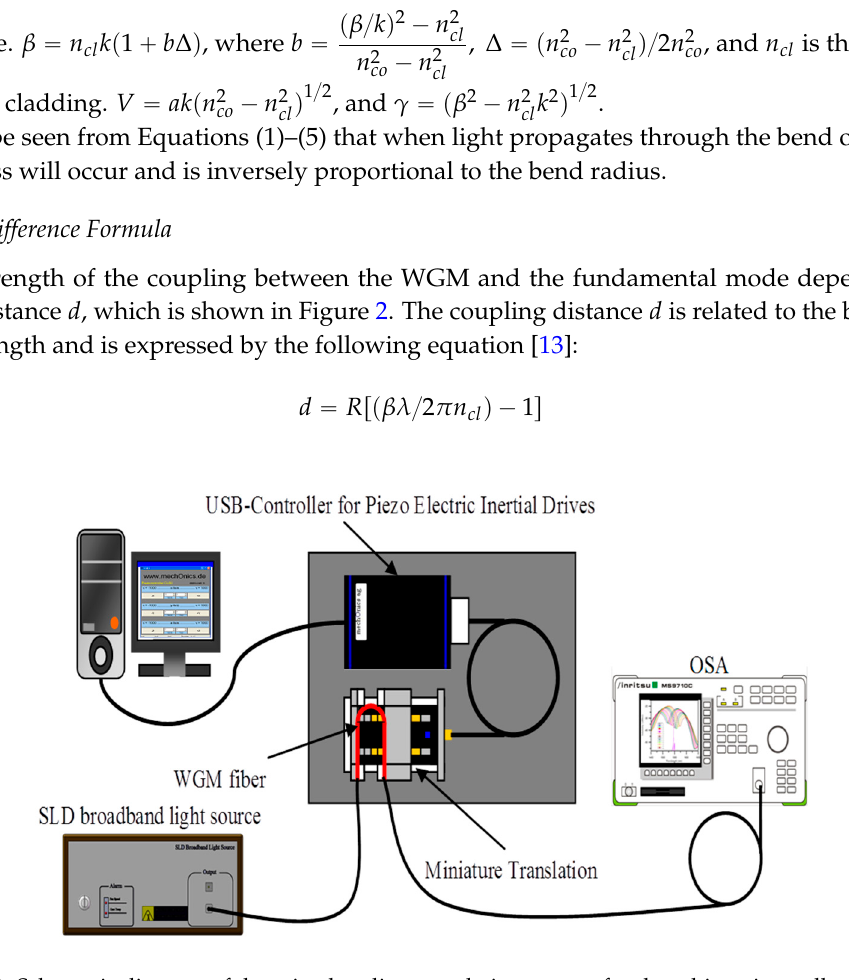
Figure 2. Schematic diagram of the microbending translation system for the whispering gallery mode (WGM) edge filter. SLD: superluminescent diode; OSA: optical spectrum analyzer. (WGM) edge filter. SLD: superluminescent diode; OSA: optical spectrum